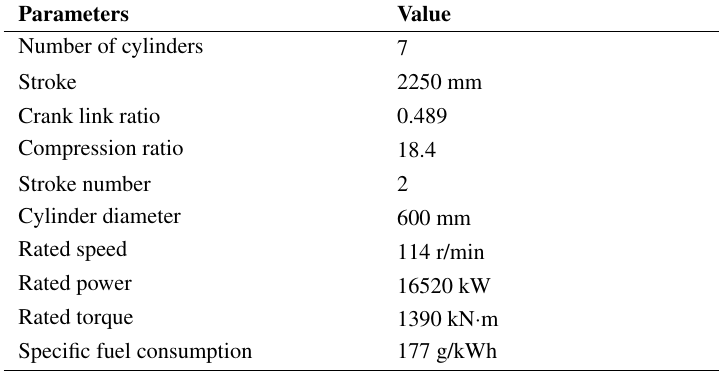
Table 1 Parameters of the RT-Flex60C